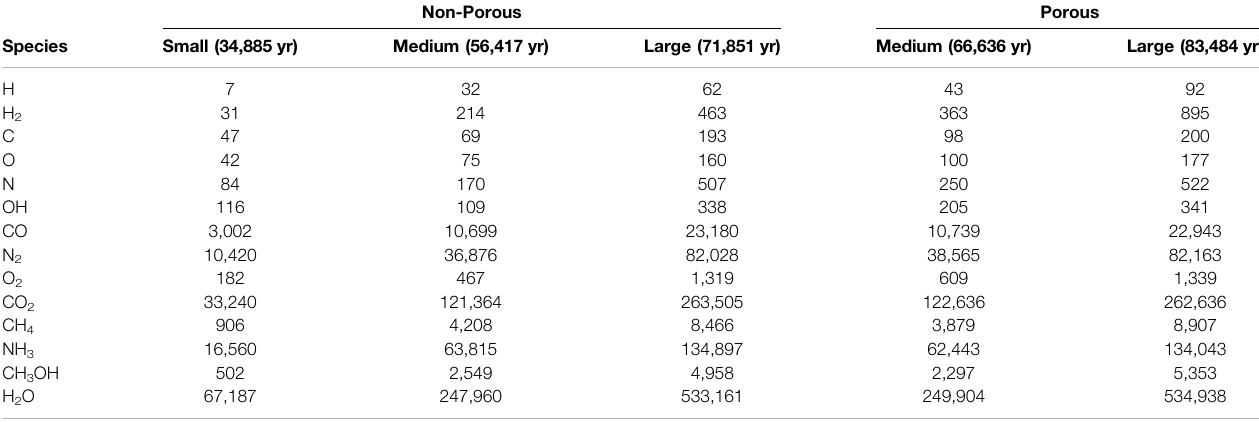
shown are the mean fi nal populations of the three random TABLE 5 | The fractional abundance of some notable ice species relative to the number-seed runs for each setup. The fi nal time in each total water ice, averaged over three runs. model is also indicated. Table 5 shows the same population Non-Porous Porous data given as a fraction of the total water on the grains, which Species Small Medium Large allows an easier comparison between models. The porous grains take a little longer to reach their fi nal state (i.e., the same amount of ice) as, compared with their non-porous equivalents, the porous grains present slightly smaller accretion cross sections.